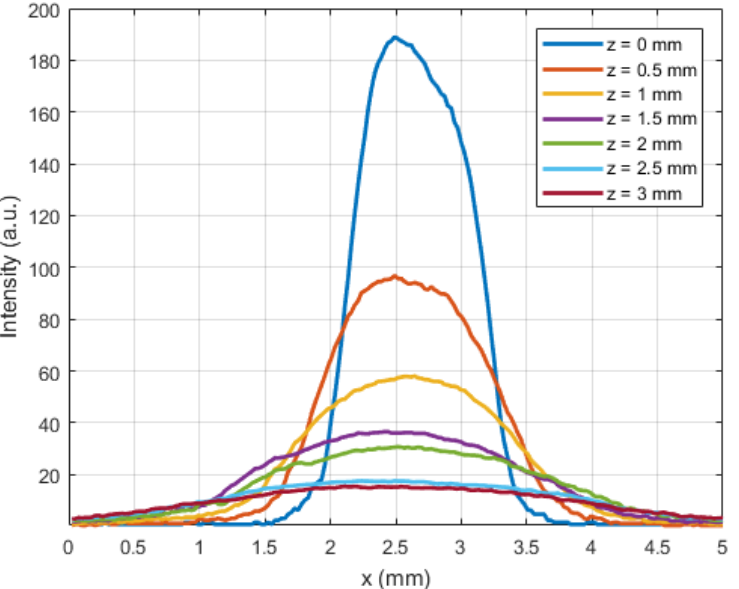
Figure 9. Light intensity profile measured along the x axis as a function of the axial beam coordinate z.